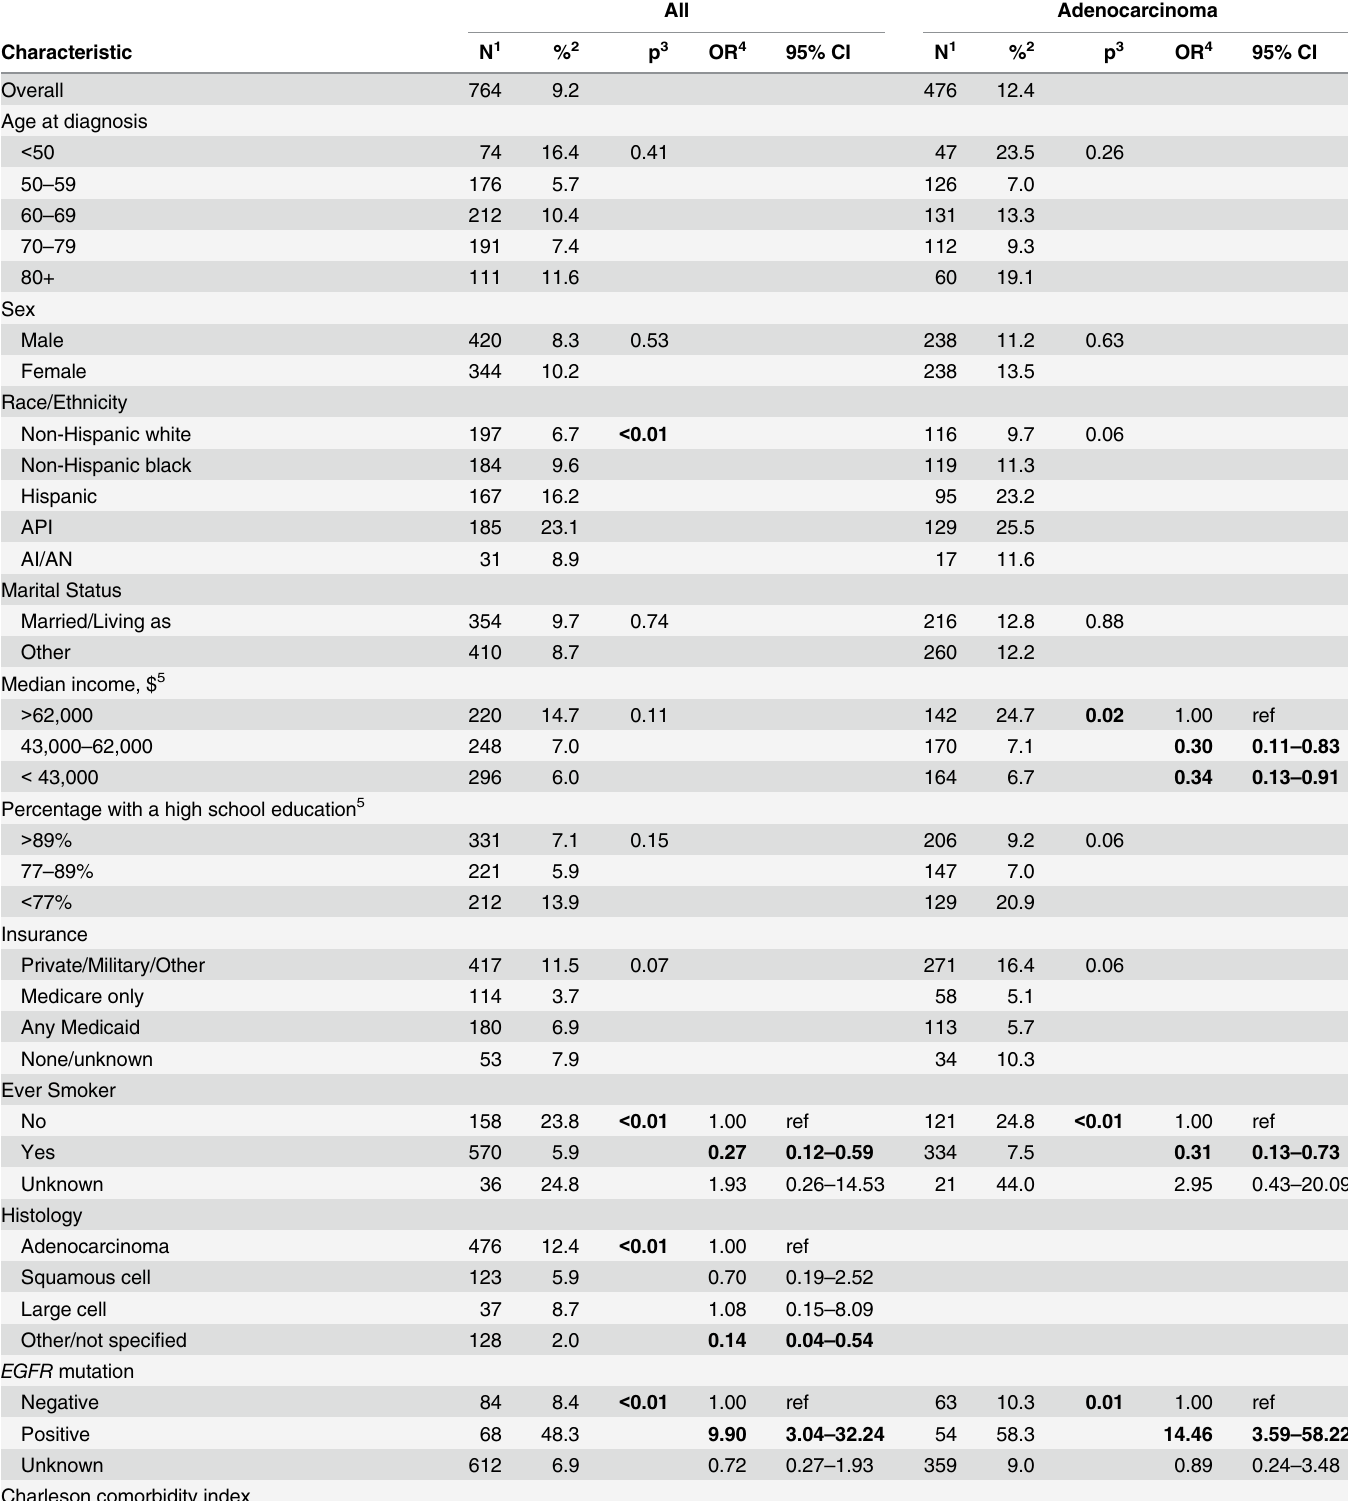
Table 4. Factors associated with receipt of Erlotinib among patients diagnosed in 2010 with stage IV non-small cell lung cancer, Patterns of Care.